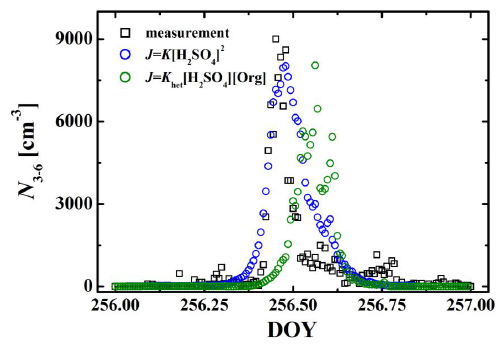
Figure 6. Measured and modelled particle number concentrations in the size range 3-6 nm ( N 3-6 ) on September 12. Black square: measurement, blue circle: modelled with kinetic nucleation mechanism, green circle: modelled with homogenous heteromolecular kinetic nucleation mechanism.